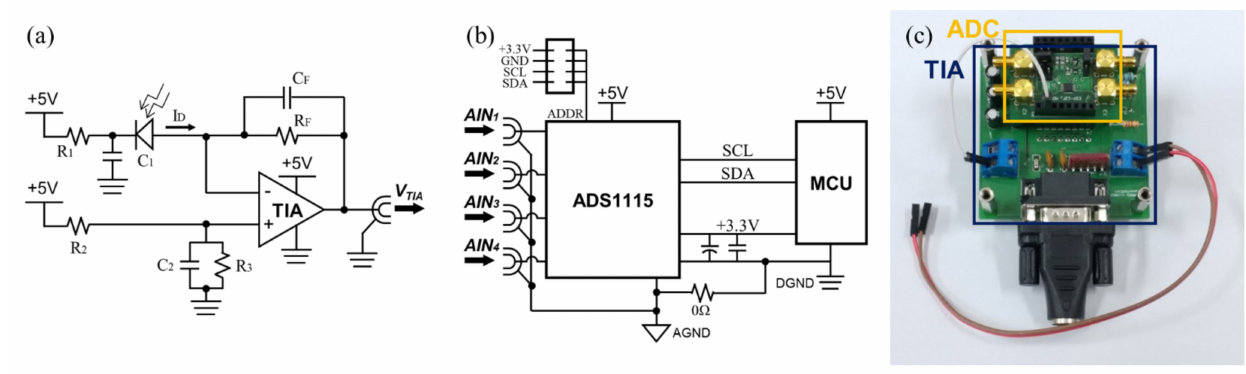
Figure A1. Electronic schematics for ( a ) the trans-impedance amplifier (TIA) circuit and ( b ) the analog-to-digital converter (ADC) circuit. ( c ) A photograph of the combined circuit boards for the laser power controller